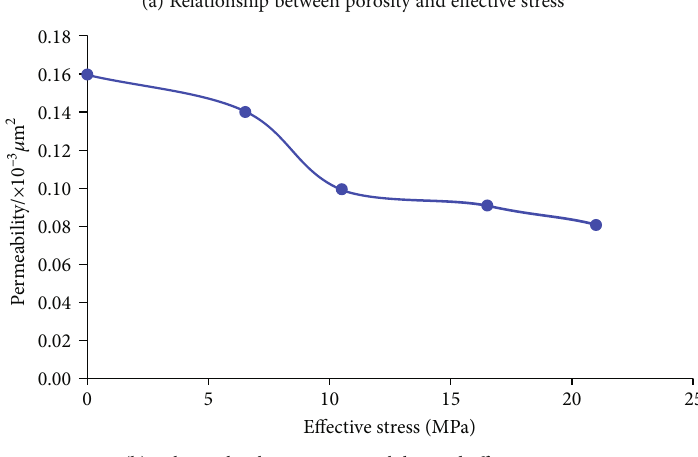
(a) Relationship between porosity and e ff ective stress